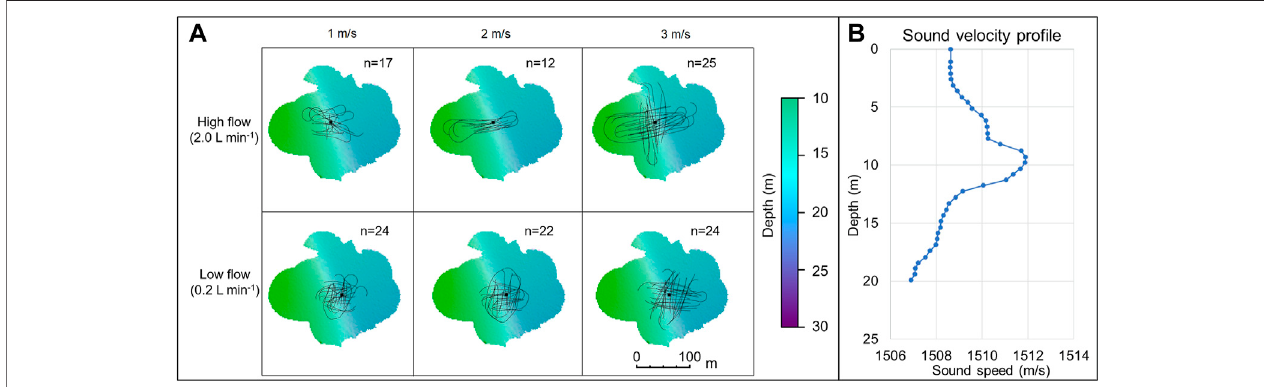
FIGURE 2 | (A) Survey lines (solid black lines) are shown for combination of high fl ow (2 L min − 1 ) and low fl ow rates (0.2 L min − 1 ) (image rows) at three vessel speedsof1,2and3 m/s(imagecolumns).Theblacksquaresrepresentthelocationsofbubblereleasesystem.nisthenumberofsurveylinesrunforeachcon fi guration. The scale bar shows distance in meters. The color scale shows bathymetry depth in meters between 10 and 30. (B) Sound velocity pro fi le from survey area.